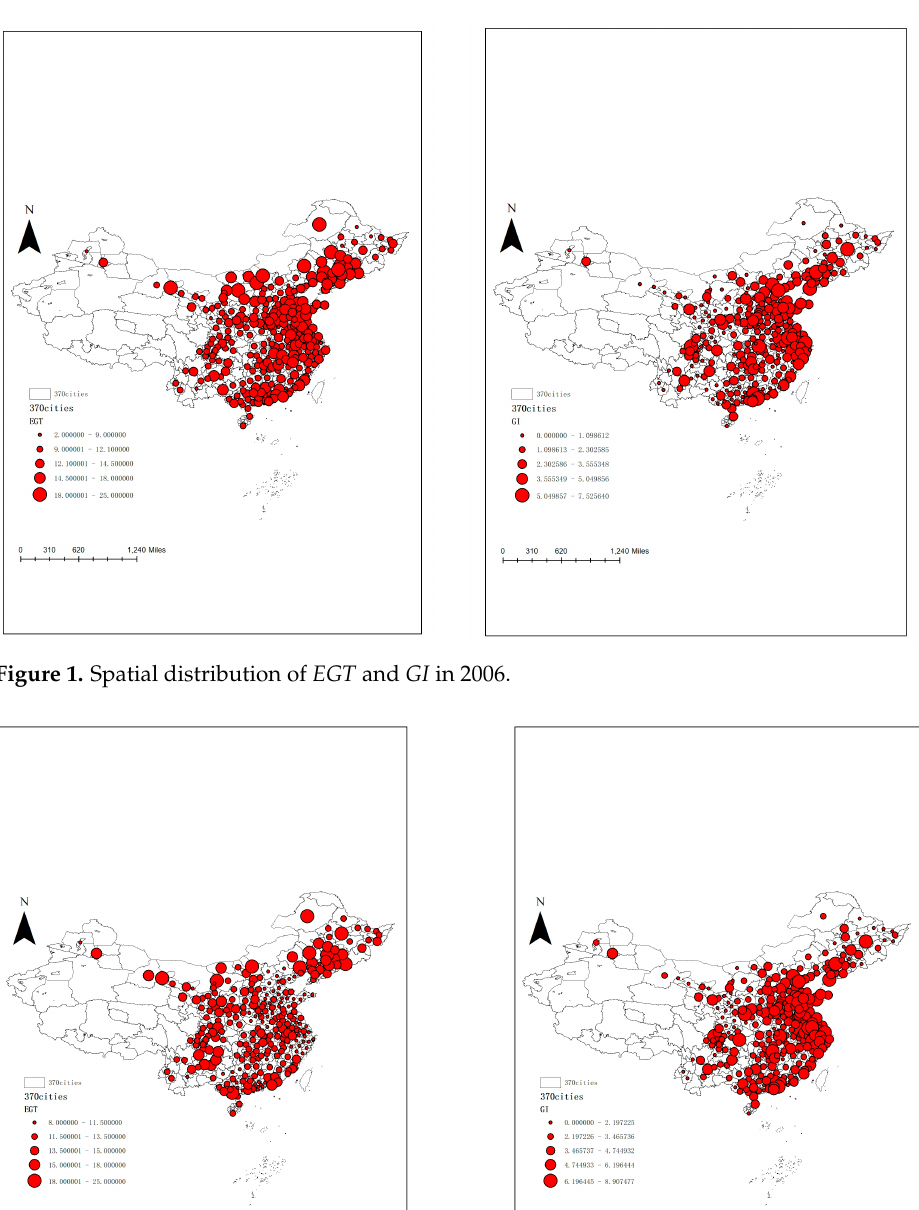
Figure 2. Spatial distribution of EGT and GI in